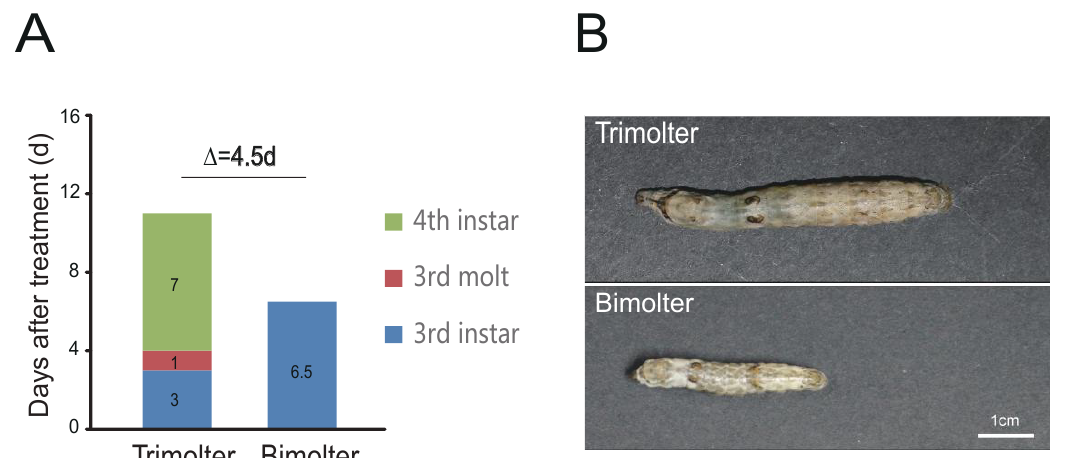
Figure 1. Schematic diagram of the developmental progression di ff erence after separately applying KK-42 and acetone. ( A ) The bimolters were trimolters treated with KK-42 on day 1 of the third instar, and the control group were trimolters treated with the same volume of acetone on day 1 of the third instar. ( B ) Morphologies of the trimolter and bimolter before wandering. Bars represent 1 cm.